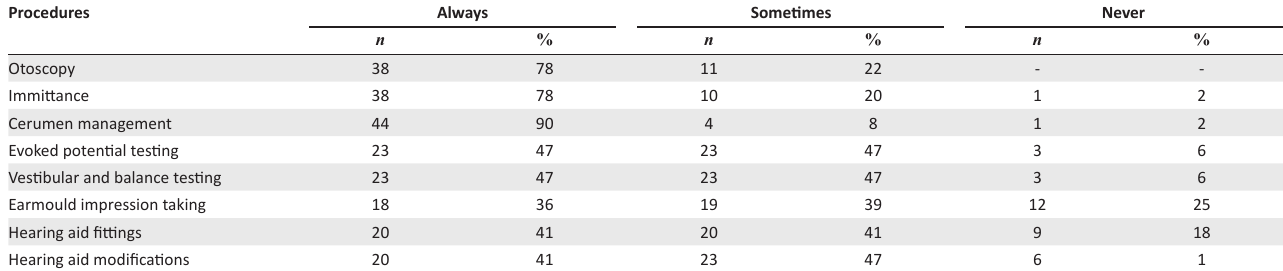
TABLE 5: Use of gloves during audiological procedures. Procedures Always